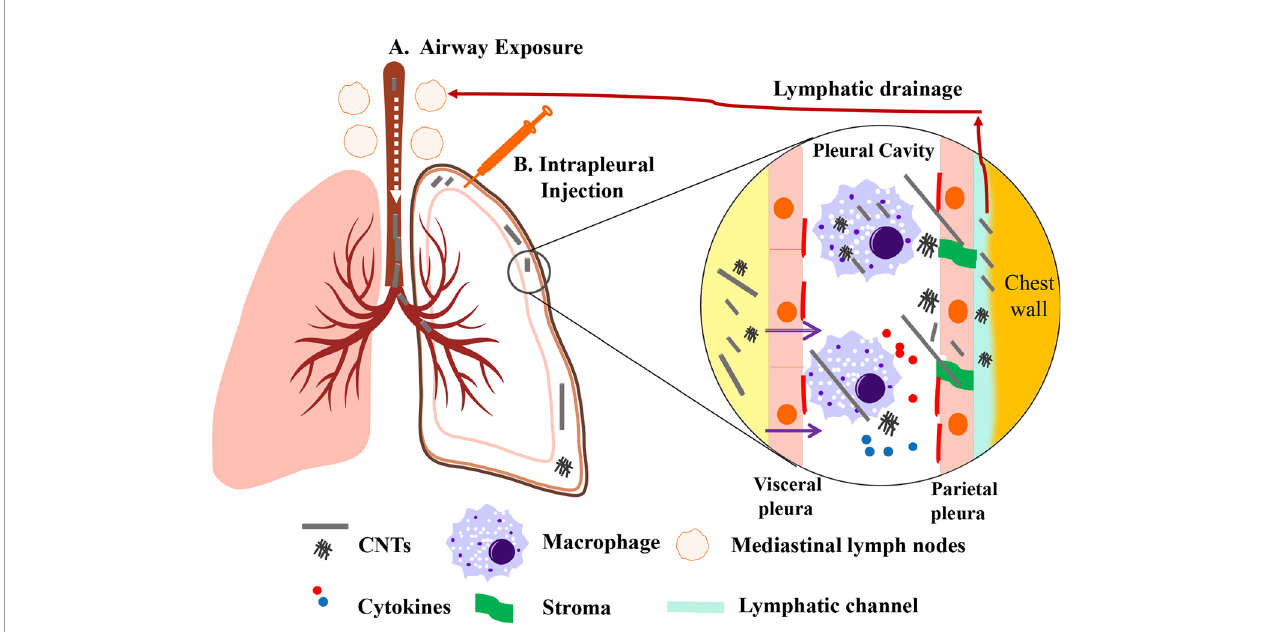
FIGURE 1 | Representative scheme of CNT drainage and pathological lesions induced by CNTs. CNT administered through airway exposure then penetrates the pulmonary alveoli and visceral pleura into the pleural cavity (A) . CNT can also be administered to pleural cavity through intrapleural injection (B) . Small-sized CNT or CNT aggregates lead to mild pathological lesions due to its engulfment by macrophages and lymphatic drainage. Long, rigid, and needlelike CNTs deposited in pleural cavity fail to negotiate with the stroma. It can induce pro-in fl ammatory cytokines and oxidants released by macrophages due to frustrated phagocytosis. Long CNTs are located in fi brotic parietal pleura, while a few CNTs could pierce and penetrate into the parietal mesothelium. [Modi fi ed from